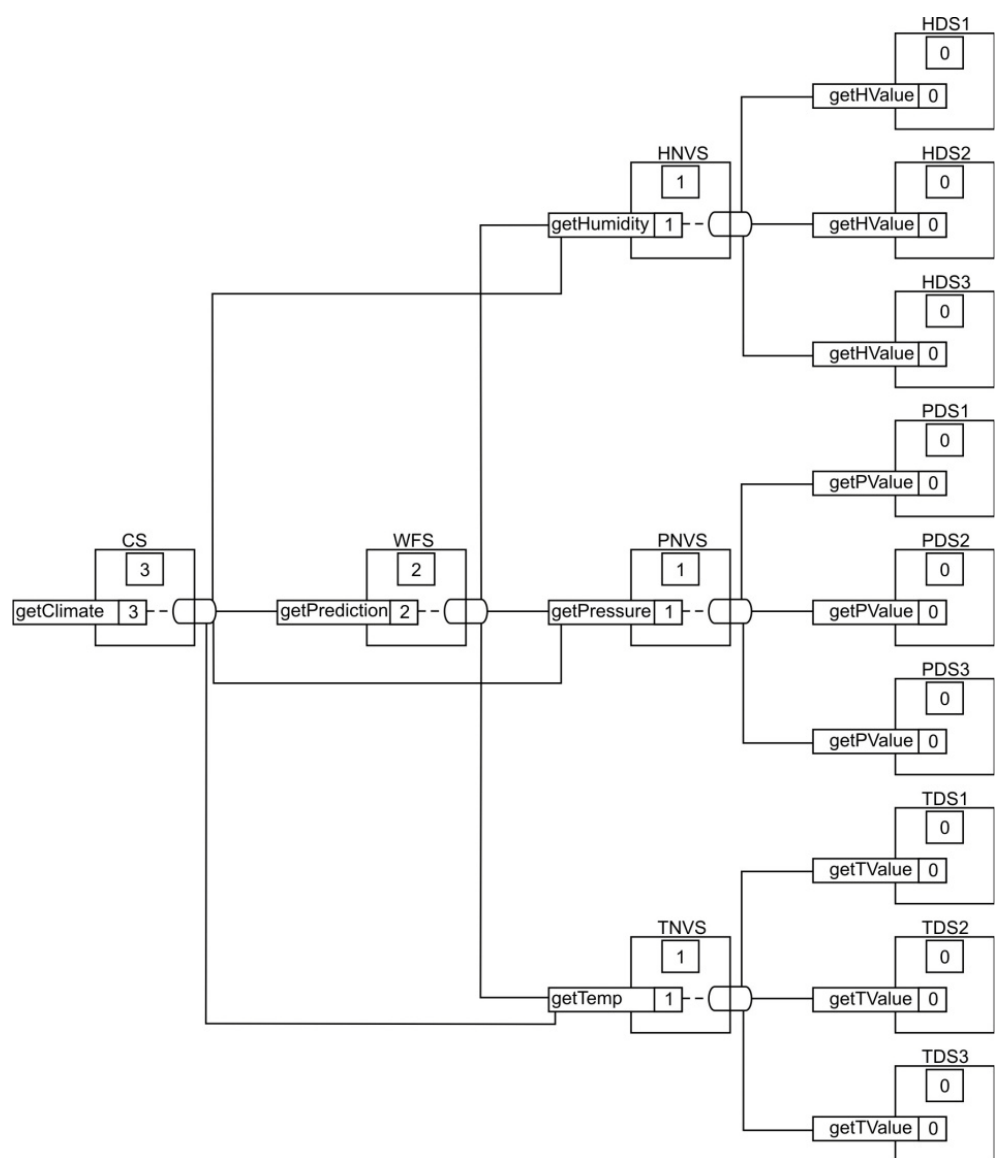
Figure 4. Full composition map of the